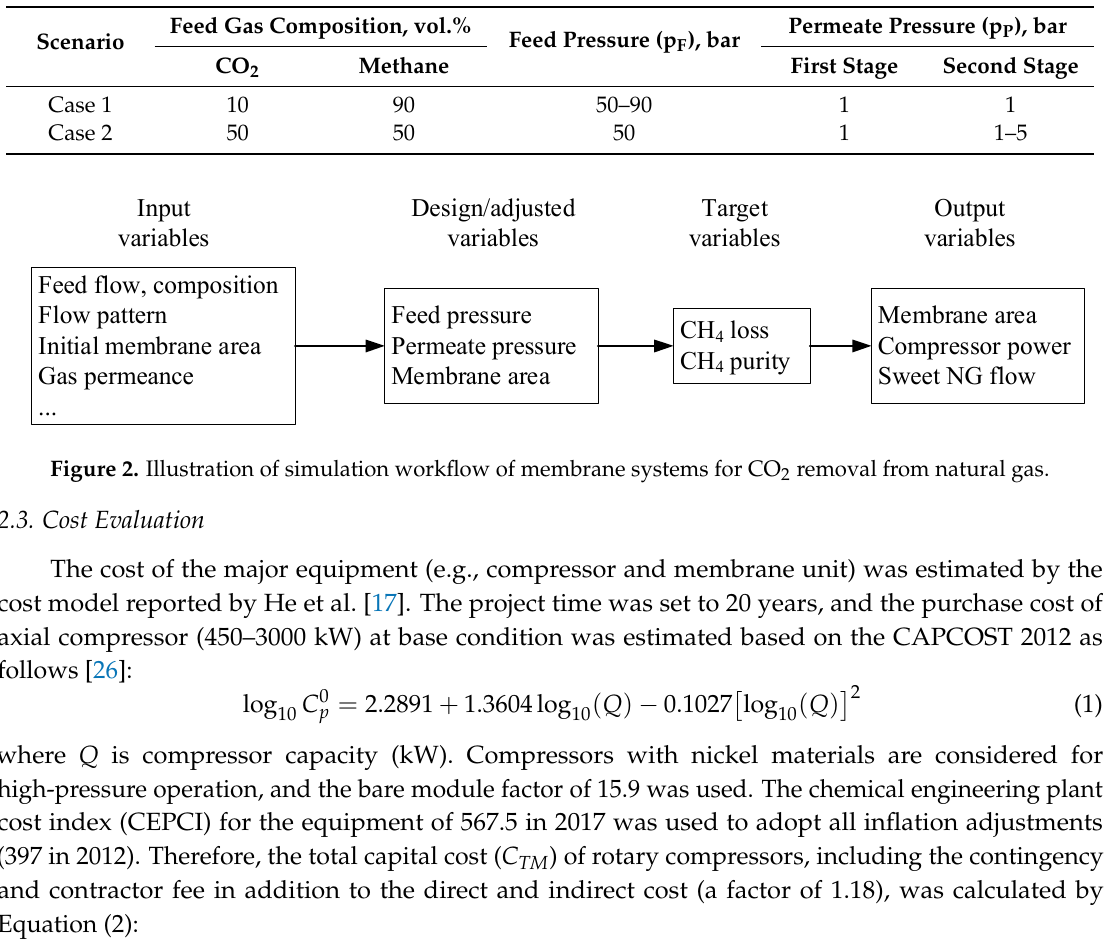
Table 2. List of different simulation scenarios.